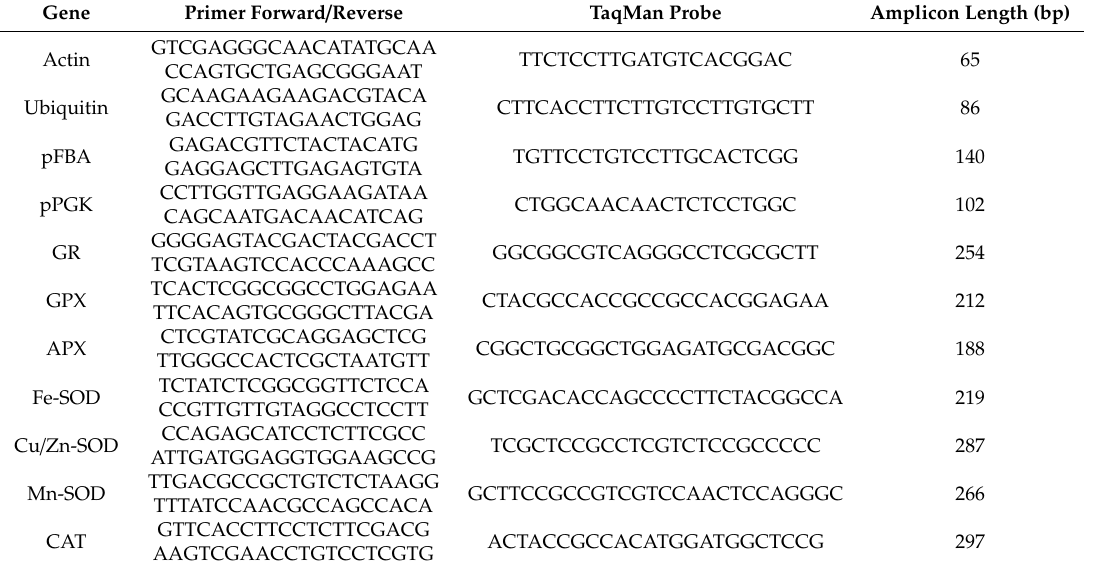
Table 1. Primers, probe sequences, and amplicon lengths of reference and target genes used for RT-qPCR